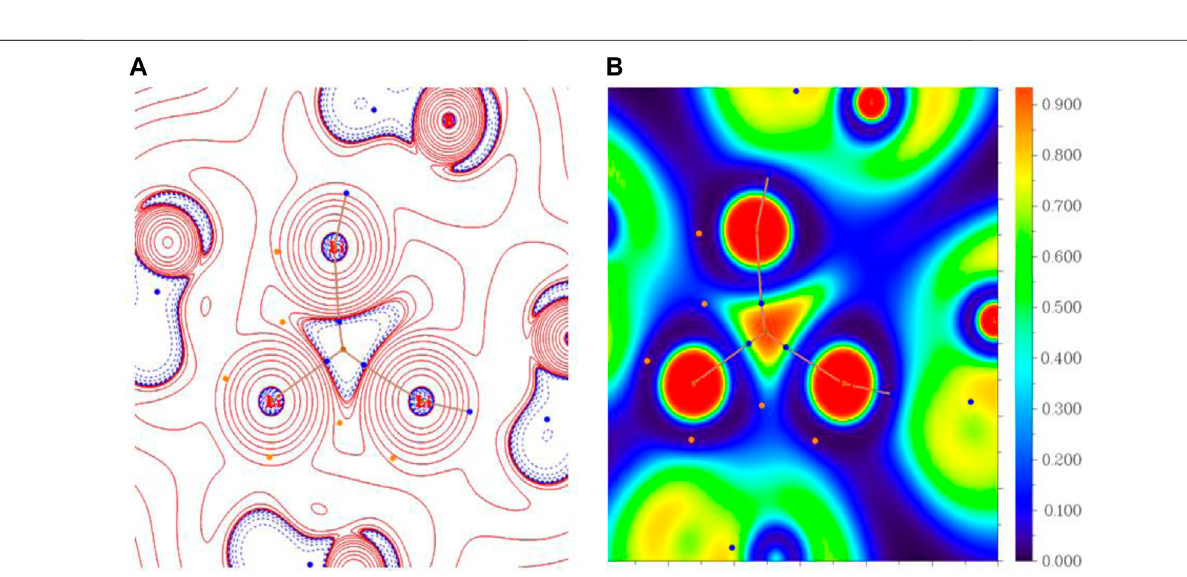
Figure 8B . From the plot, it is shown that a basin is present at the center of the Li 3 cluster for both systems. The basin population is 0.58 | e | with 22% localization of electron density for the Li 3 @B 40 system. However, for the Li 3 @C 60 system, the population of the basin is 1.01 | e | with 56% localization of electron density. The ELF basin population of the Li 3 @C 60 system is higher than that of the Li 3 @B 40 system. The lowering of the basin population for the Li 3 @B 40 system is due to the electron-de fi cient nature of boron (B) atoms. From these results, it can be said that a portion of electron density is localized at the center of the Li 3 cluster in both the systems. The higher values of NNA and ELF populations at the center of the